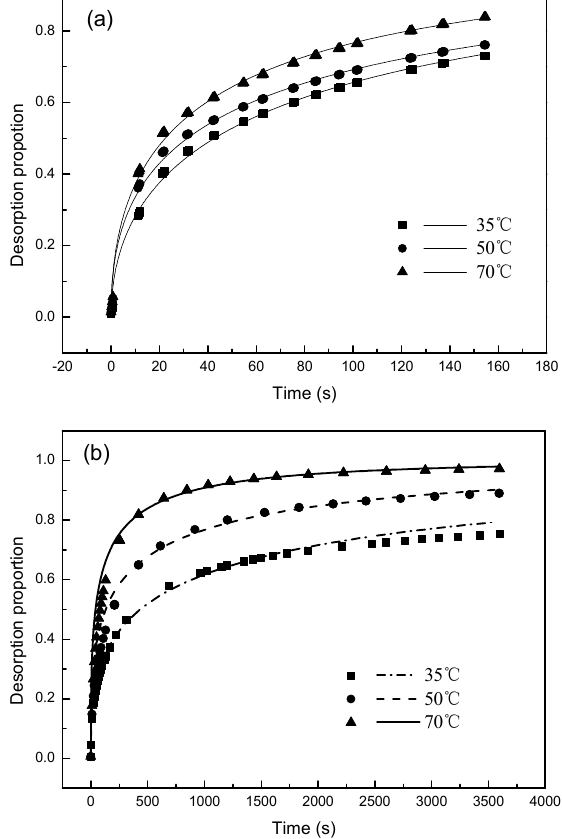
Figure 2. Desorptioncurves of proportion. ( a ) Physical desorption; ( b ) chemical desorption.